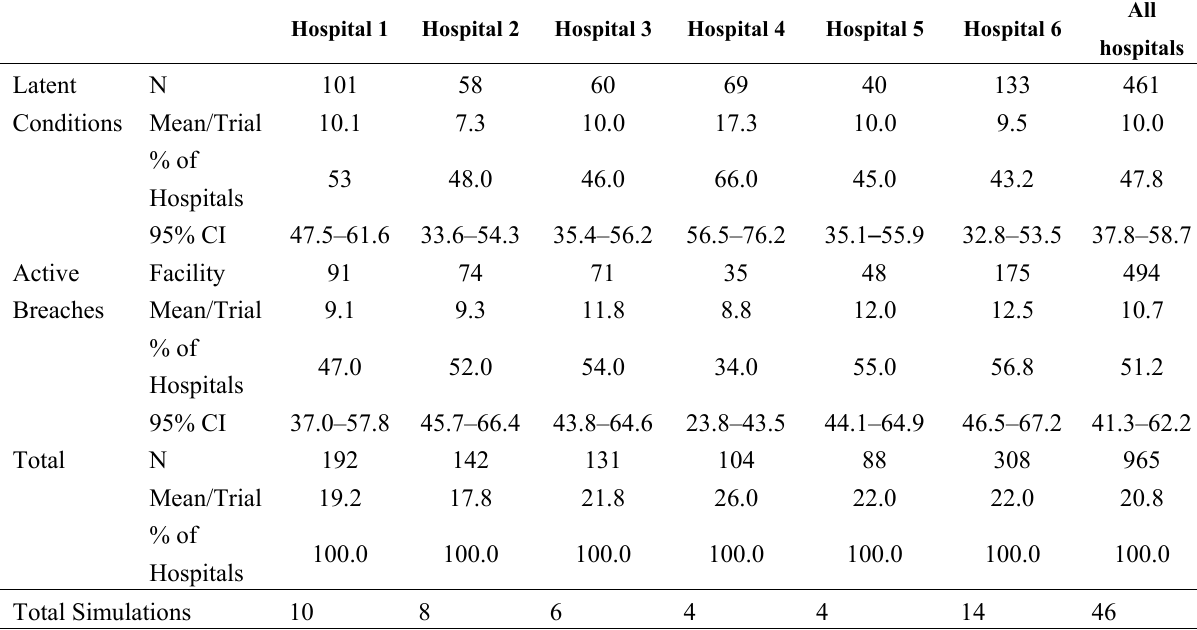
Table 9. Raw numbers and proportion of breaches by hospital and per simulation: latent conditions and active breaches [36].